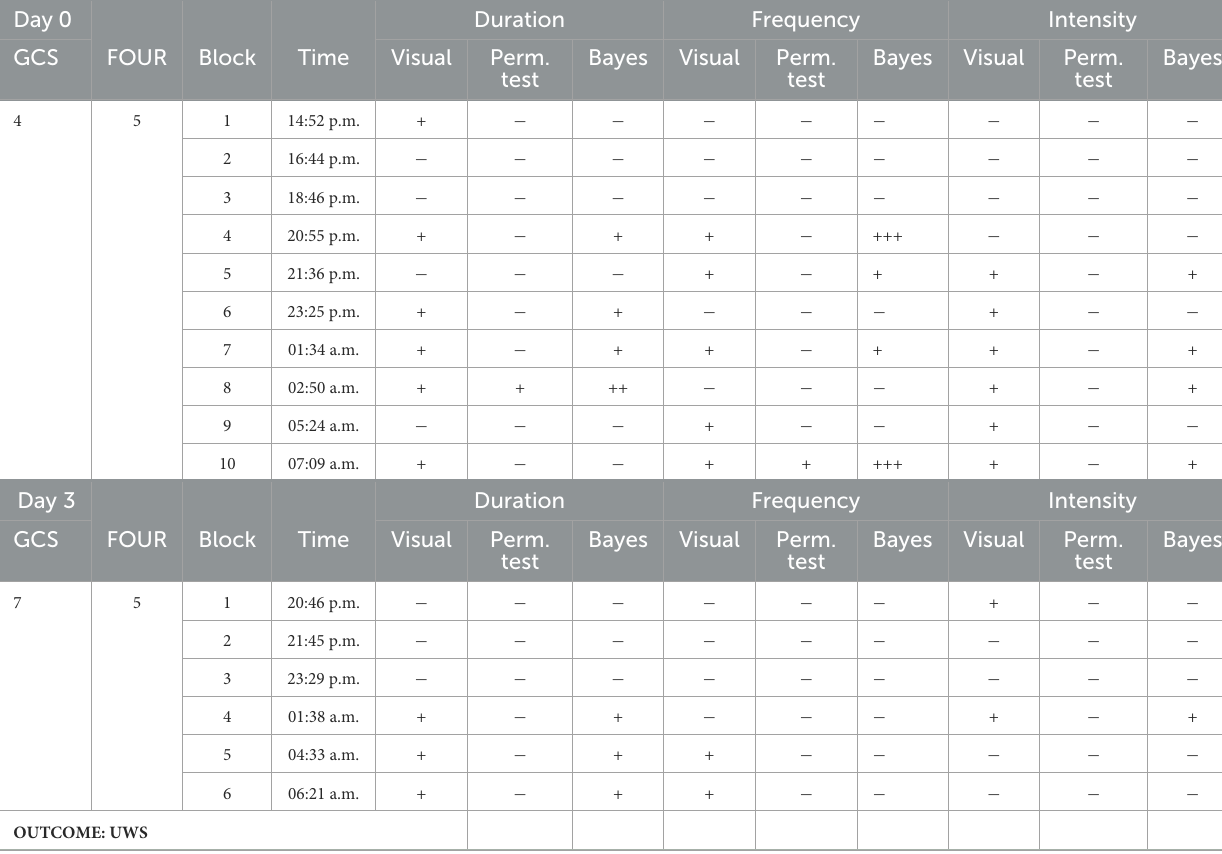
Bayes Visual Perm. Bayes Visual Perm. Bayes test test test